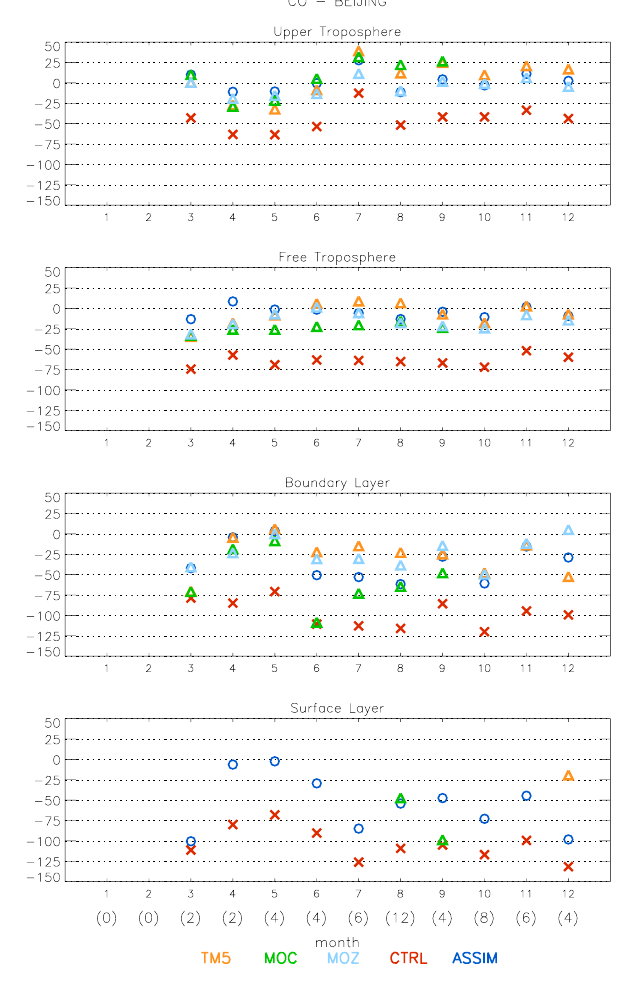
Fig. 6. Same as Fig. 5 except over